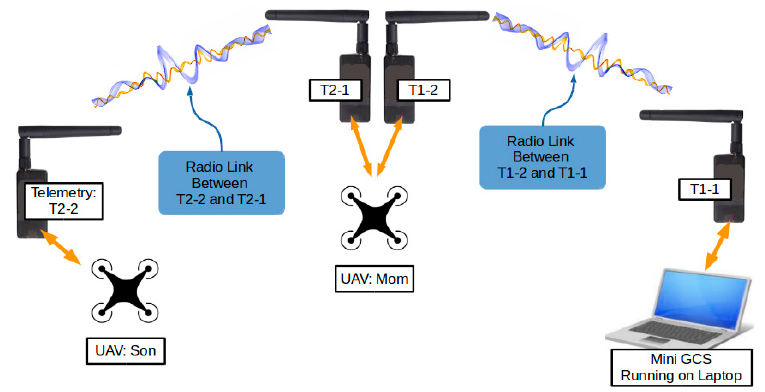
Figure 4. Radio communication relay setup. Table 1. Telemetry Installation and Settings.